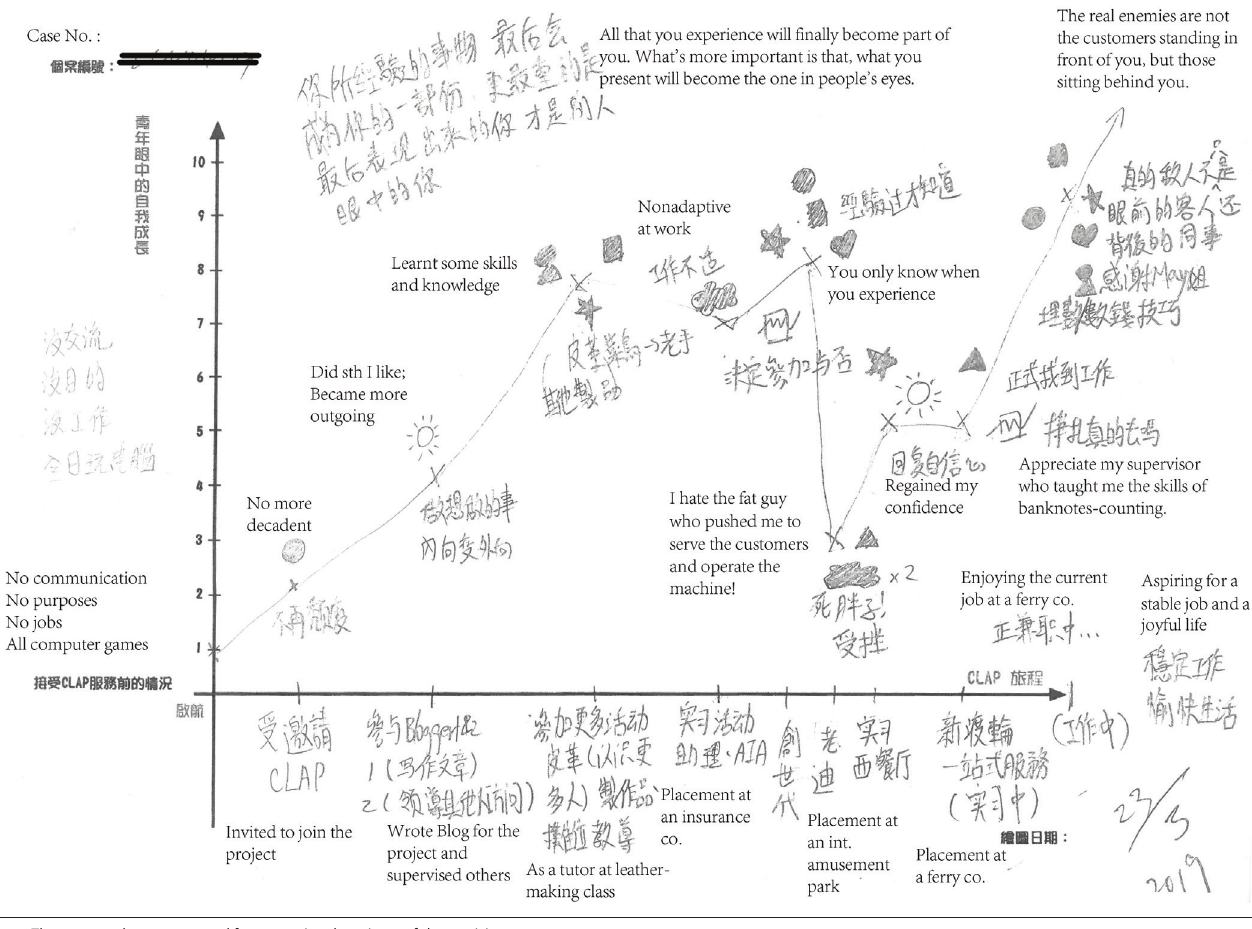
FIGURE 1: A user journey mapped out by